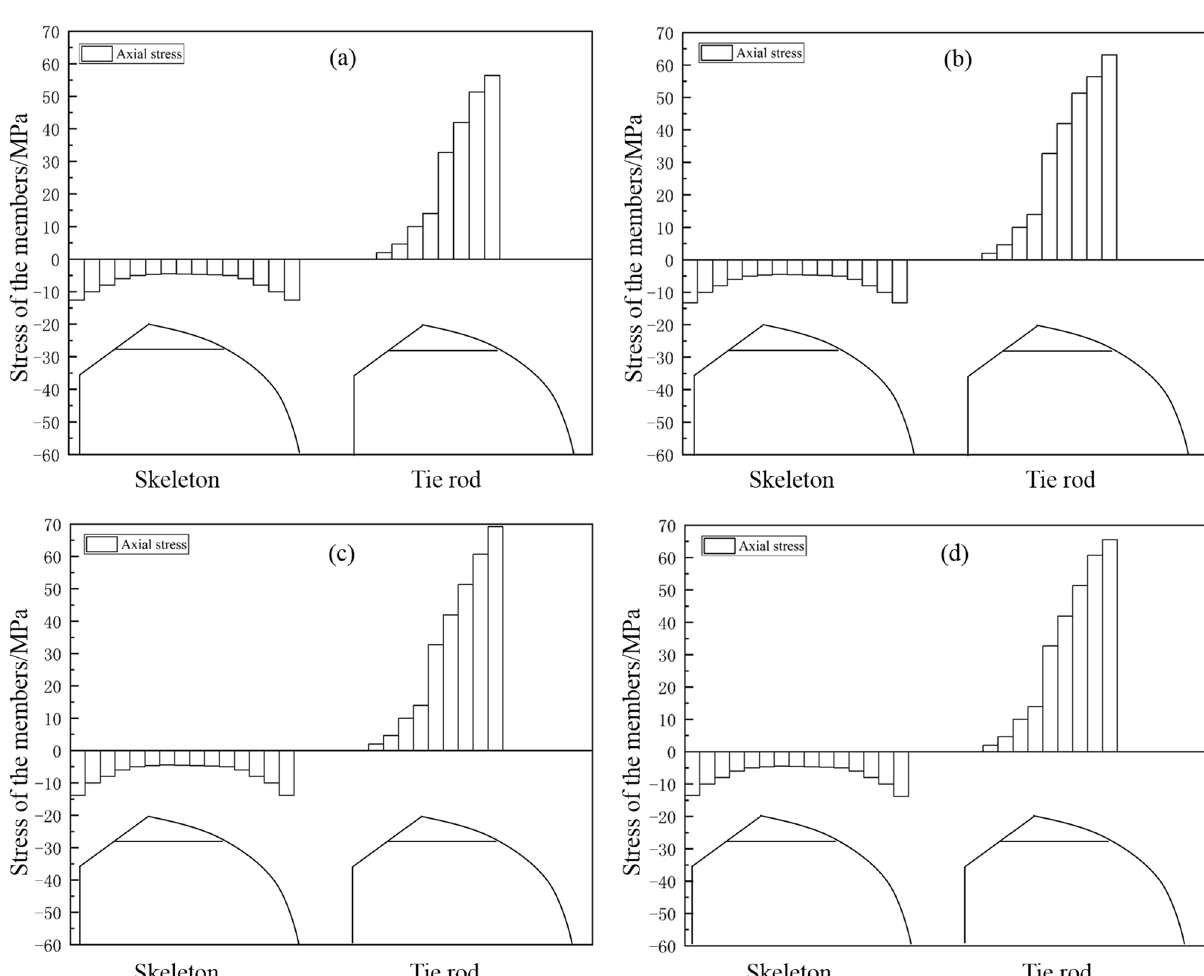
Figure 10. Normal stress diagram of greenhouse skeleton under non-uniform snow load condition: ( a ) round tube; ( b ) square tube; ( c ) Ω tube; ( d ) elliptic